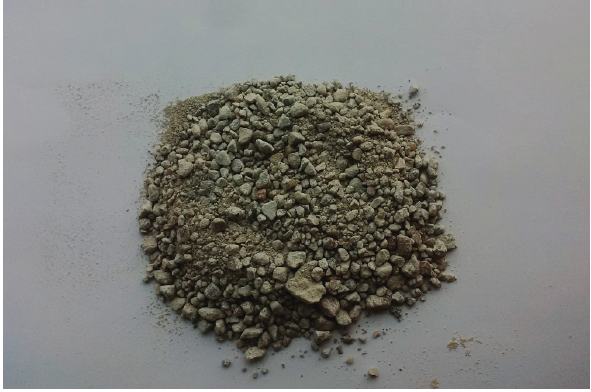
Fig. 1. Crushed concrete sample as used in testing